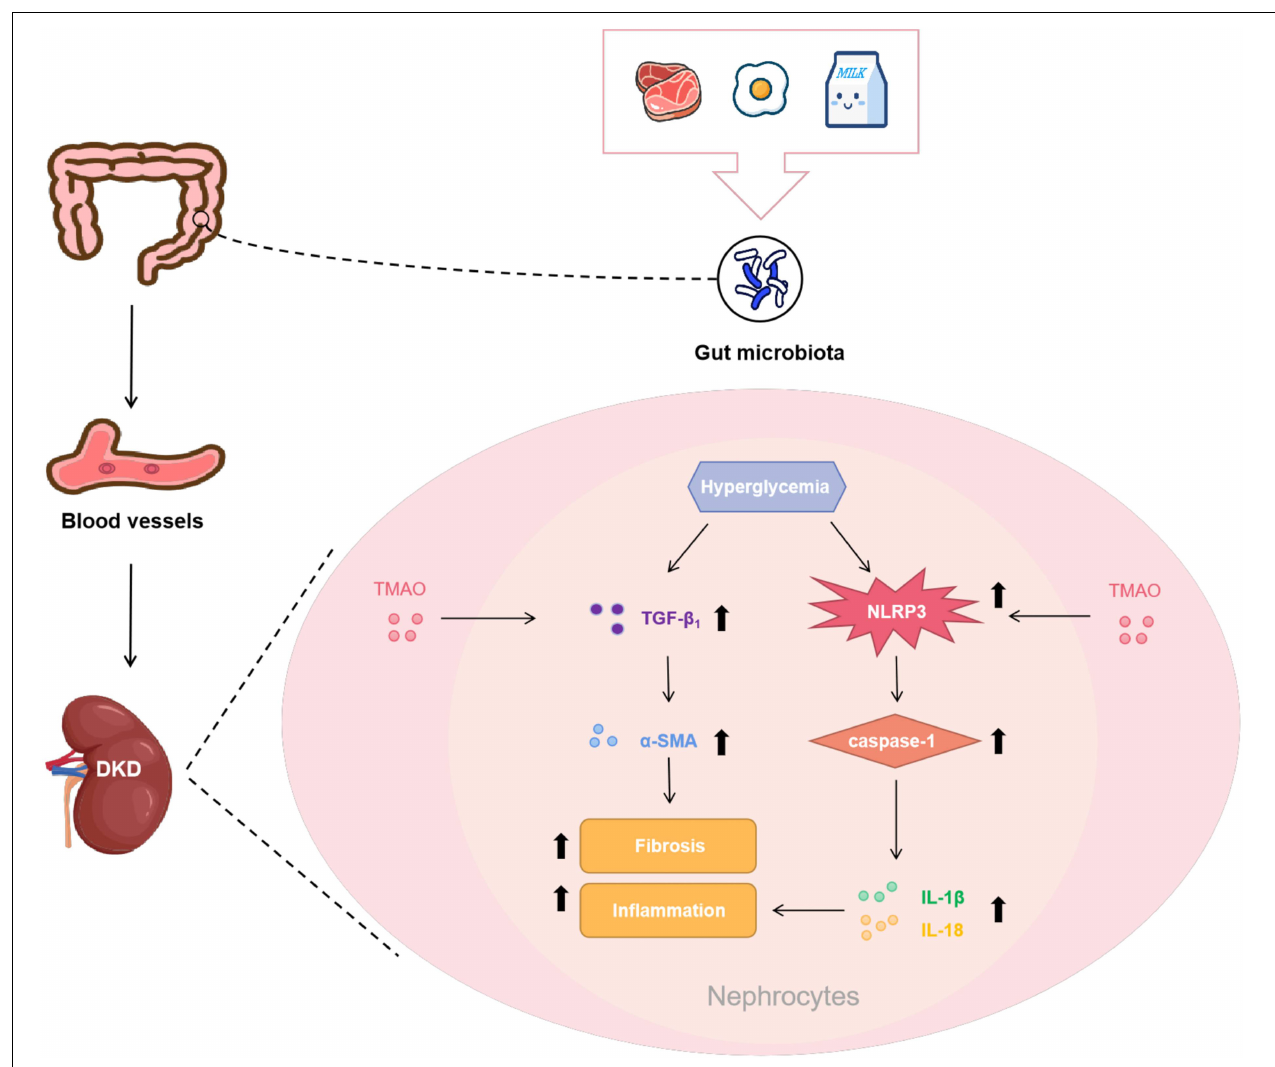
FIGURE 7 | Potential mechanisms of pro-DKD effect of TMAO. Foods like red meat, eggs and milk are digested and absorbed by the gastrointestinal tract, subsequently metabolized under the action of gut microbiota and then oxidized by the liver to form TMAO to enter the bloodstream. TMAO entered the kidney tissue with the blood, and facilitated renal fibrosis by increasing pro-fibrotic factor TGF- β 1 and its downstream molecule α -SMA. TMAO may also activated the NLRP3 inflammasome to cause the release of IL-1 β and IL-18 to promote renal inflammation. These effects together aggravated the progression of